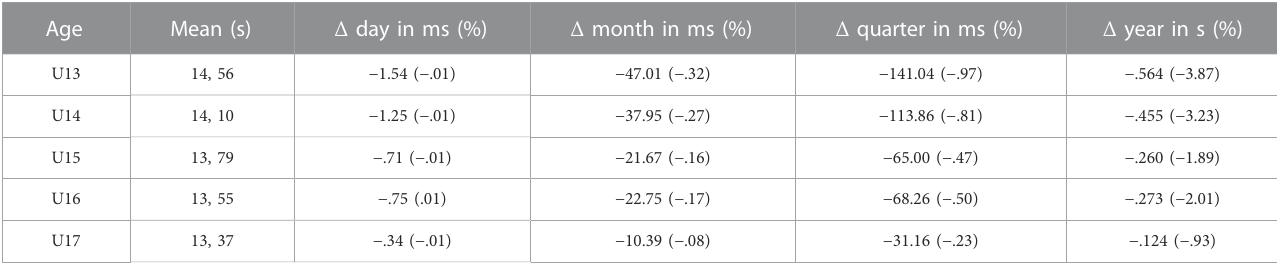
TABLE 1 Mean performance differences by year, quarter, month and day, among female 100 m sprinters, Δ , mean difference; ms, milliseconds; s, seconds; %, in percentage of performance